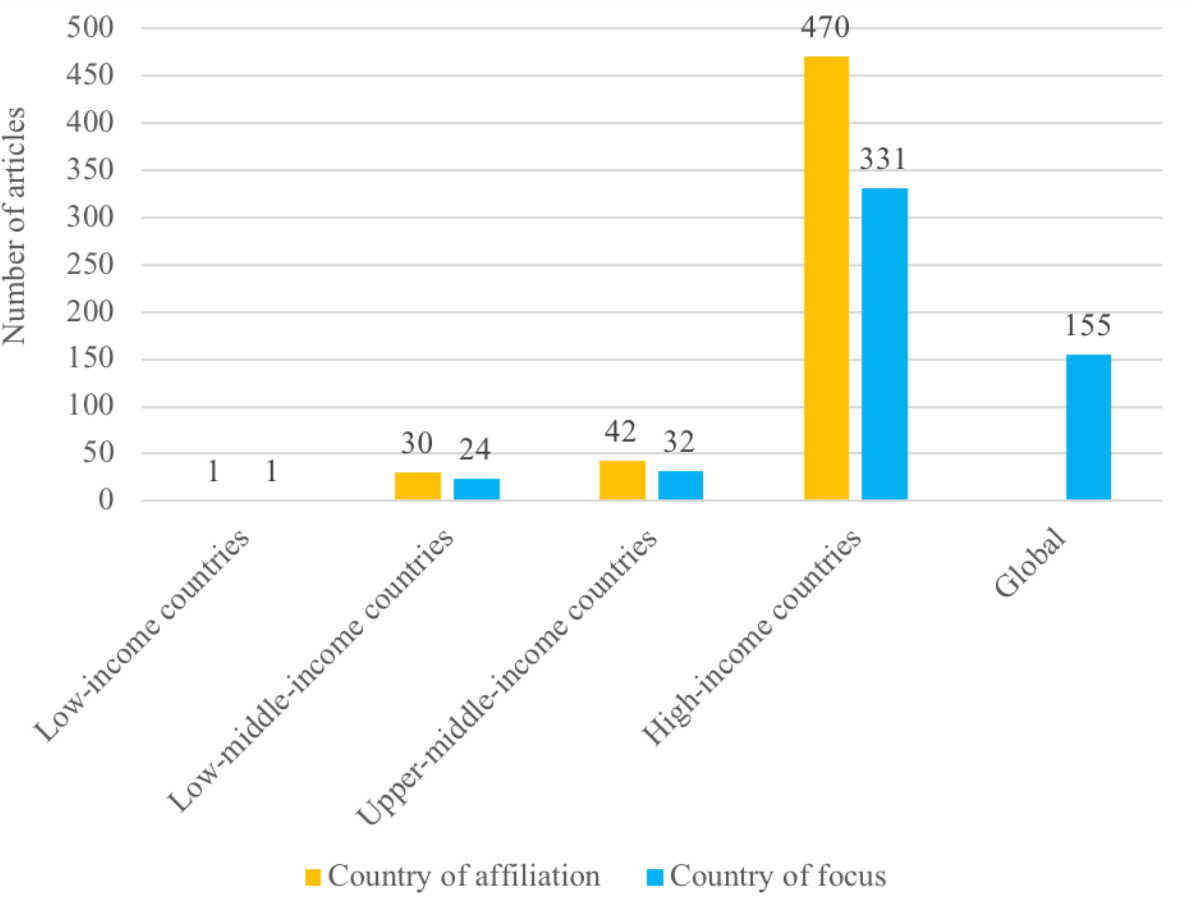
Figure 2. Number of articles based on the World Bank’s classification of countries by income level (N=543).